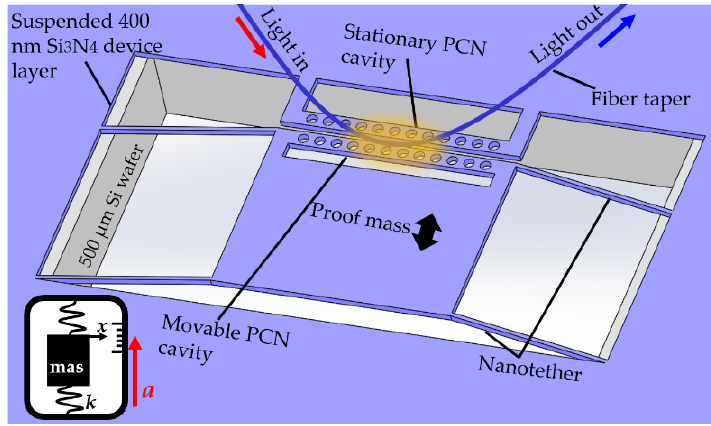
Figure 24. Schematic of PCN zipper cavity-based optomechanical accelerometer (the inset box indicates that canonical of accelerometer) [130] .